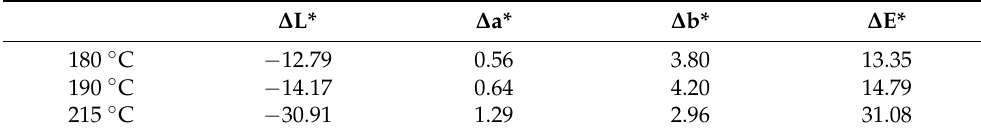
Table 4. Colour differences between untreated and heat-treated ayous